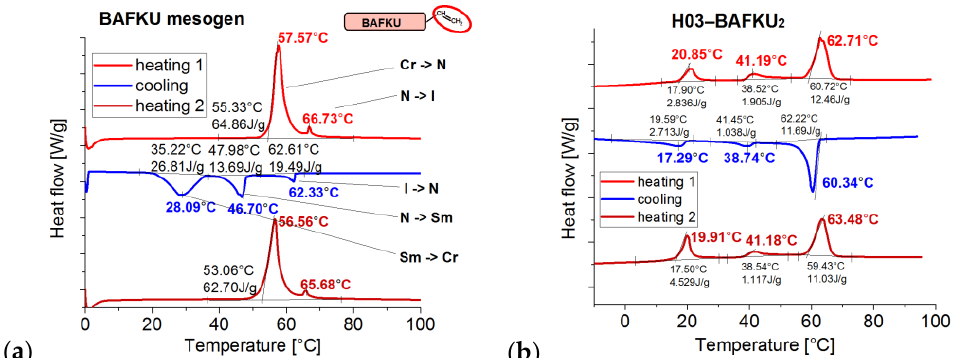
Figure 2. Differential scanning calorimetry (DSC) traces ( a ) of the neat BAFKU mesogen and ( b ) of the copolymer H03–BAFKU 2 .